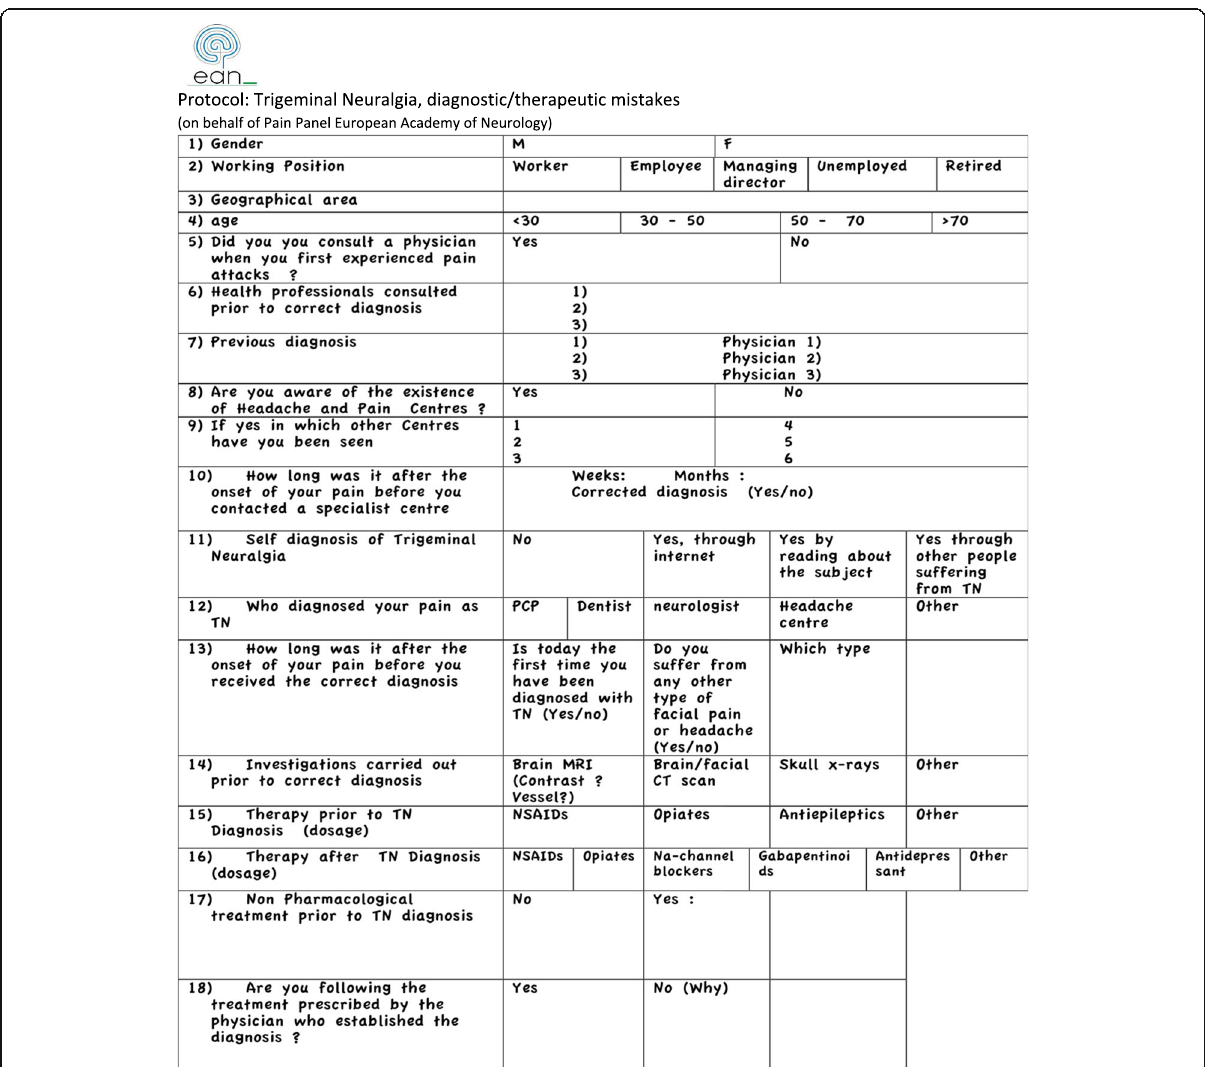
Fig. 1 Trigeminal Neuralgia Questionnaire. Protocol: Trigeminal Neuralgia, diagnostic/therapeutic mistakes (on behalf of Pain Panel European Academy of Neurology)